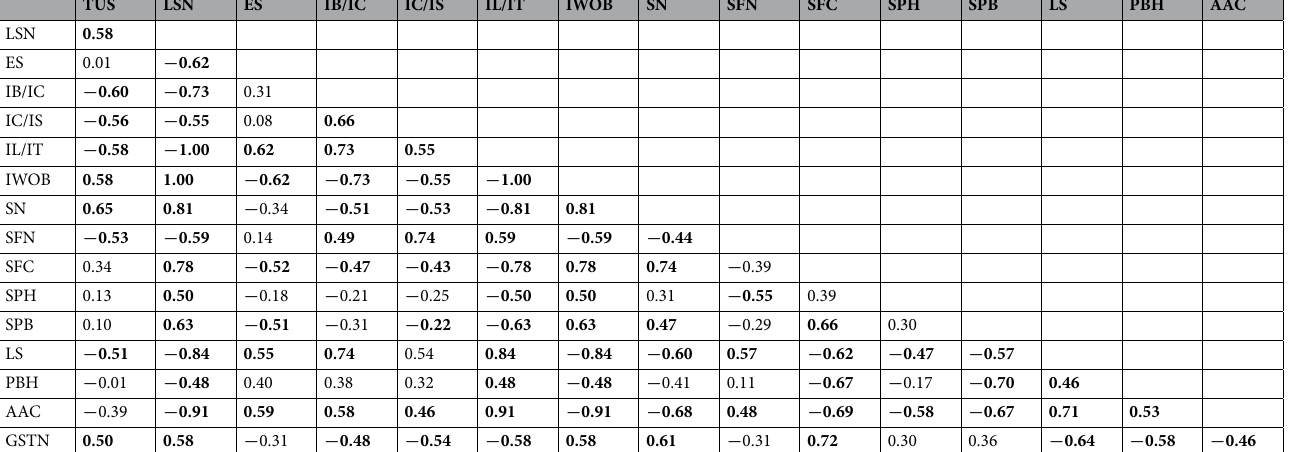
Table 3. Pearson’s correlation coefficients between the significant discriminatory characteristics as indicated by the Kruskal–Wallis test results in Table 2. Values highlighted in bold are statistically significant at P < 0.01( ** ).